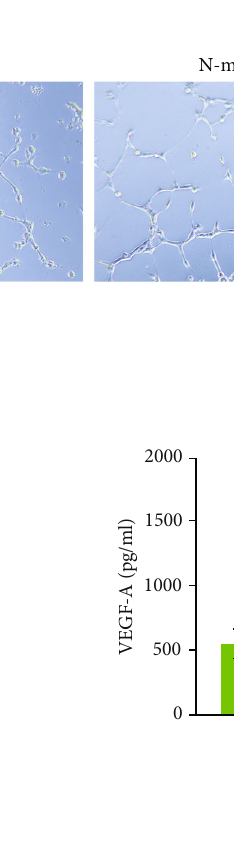
Figure 4: (a) Live/dead cell analysis for the ADM membrane on which ADSCs had been seeded and cultured under normoxic or hypoxic condition. Representative images show the live (green) and dead (red) ADSCs in the TCPS and the ADM membrane cultured under normoxic or hypoxic condition and the viability analysis for the cells on the TCPS and ADM membrane, n = 4 per group. (b) Scanning electron micrographs of the ADM membrane on which ADSCs had been cocultured under normoxic or hypoxic condition for 48 hours. (c) Proliferation of HUVECs in fl uenced by H medium and N medium was evaluated with Cell Counting Kit-8 (CCK8) assay at 0,1, 2, and 3 days after cell seeding, n = 4 per group. (d) Representative images of scratch on HUVECs at 0, 12, and 24 hours after treated by H medium and N medium. The migration of HUVECs was signi fi cantly increased by H medium, n = 3 per group. (e) In vitro tube formation of HUVECs at 12 hours under the stimulation of C medium and H medium. Bar = 100 μ m, n = 3 per group. (f) The content of angiogenic-related growth factors (VEGF-A, HGF, and FGF) in culture medium from hypoxia- or normoxia-preconditioned ADSCs determined by ELISA, the FGF content was too low to be measured. n = 3 per group. All data are shown as means ± standard deviation ( ∗ P < 0 : 05 , ∗∗ P < 0 : 01 , and ∗∗∗ P < 0 : 001